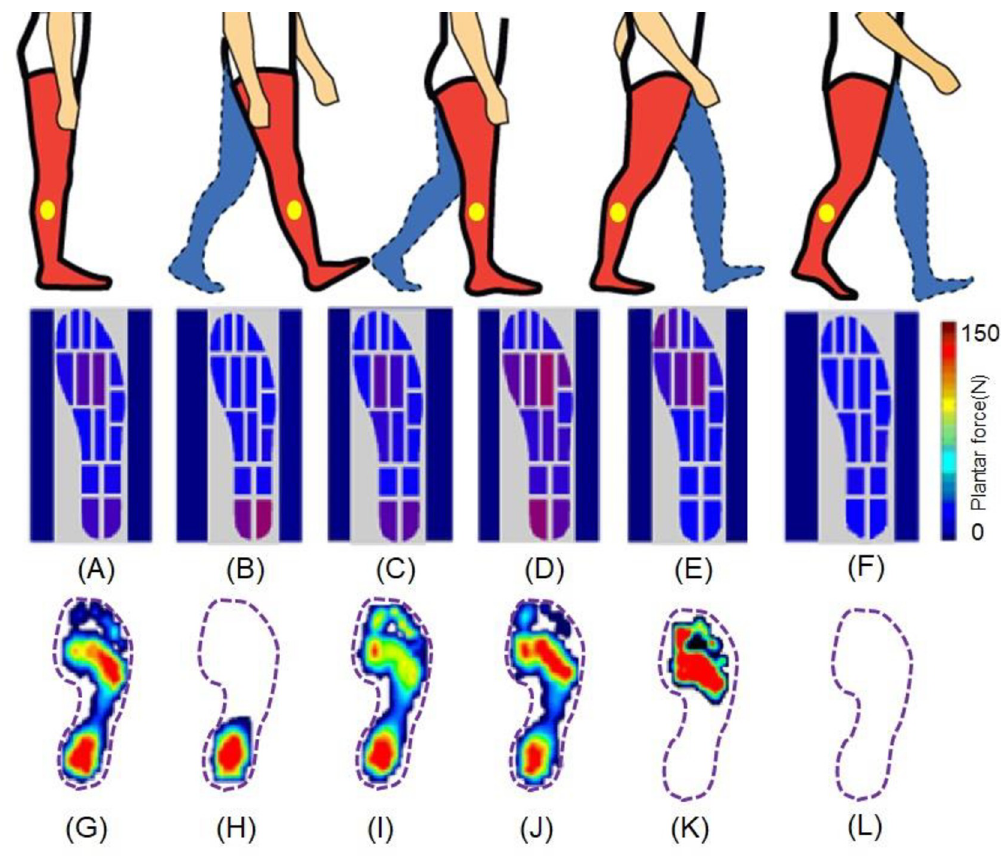
Fig 7. Comparison on the plantar pressure force distributions of the right foot under different gait phases measured by the developed sensor-film based WPPMA system (A-F), and the commercial pressure force measurement system (Gaitview 1 AFA-50 system) (G-I). (A: stance, B: heel-strike, C: foot-flat, D: midstance, and E: heel-off, and F: midswing).